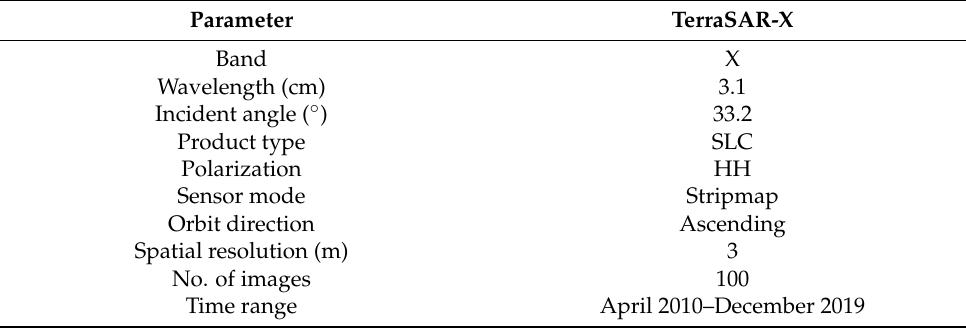
Table 2. Properties of the TerraSAR-X datasets.